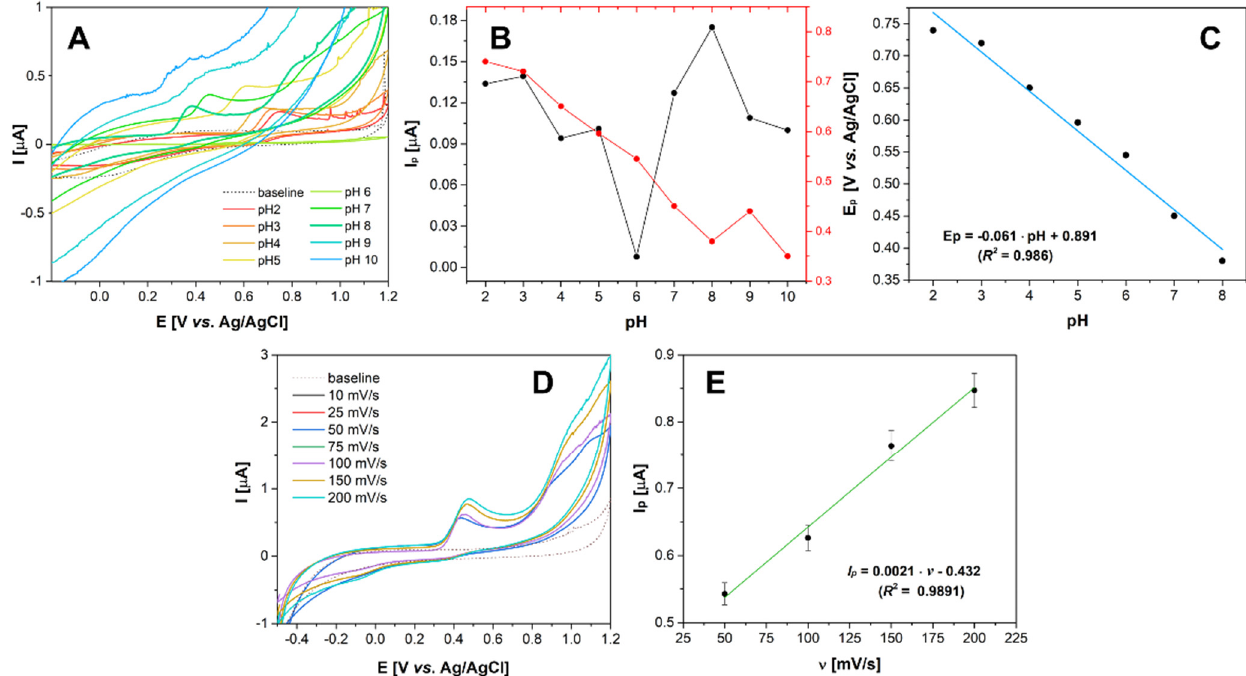
Figure 4. ( A ) CV voltammograms for 0.1 mM MORPH solution in BRBS at pH 2–10 (scan rate 50 mV/s). ( B ) Evolution of peak current and peak potential with pH. ( C ) Linear fit of E p vs. pH. ( D ) CV voltammograms for 0.1 mM solution of MORPH on BRBS at pH 8, scan rate 50–200 mV/s and ( E ) I p vs. log v.